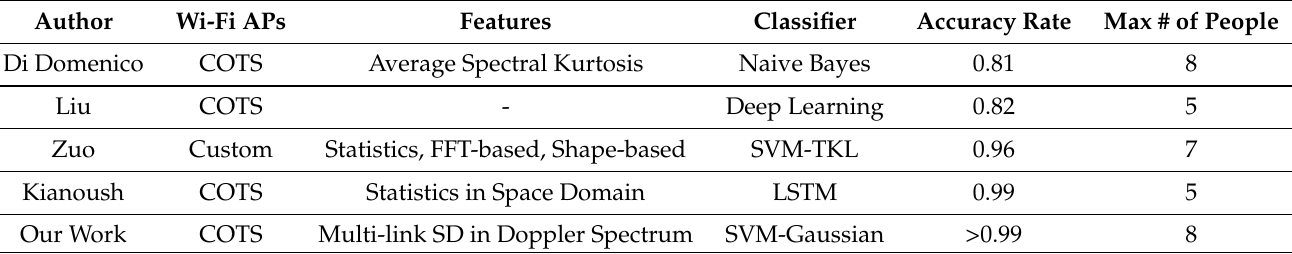
Table 11. Benchmark of accuracy rates for state-of-the-art Wi-Fi-based crowd